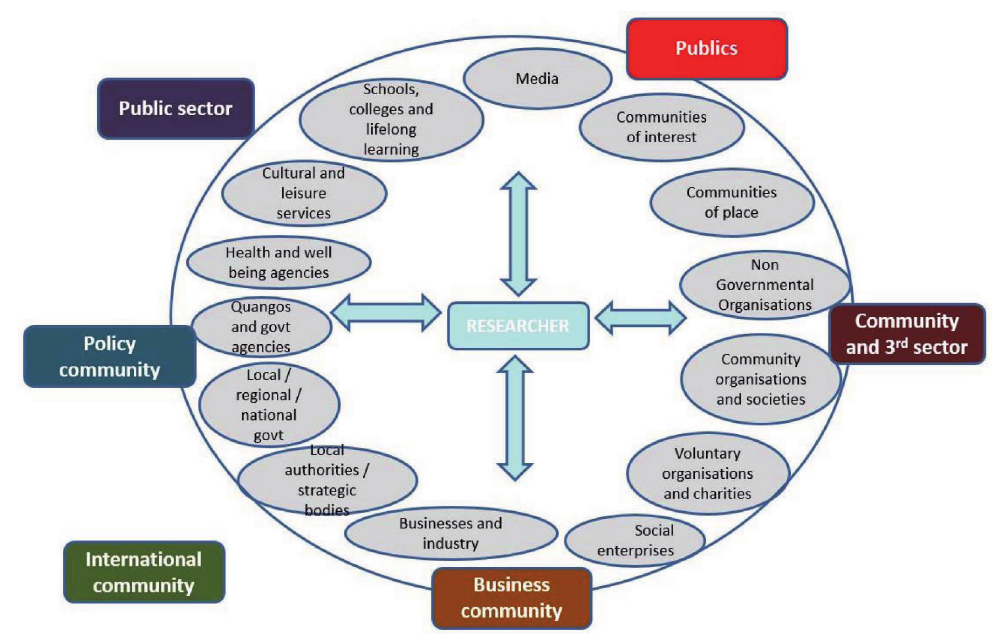
Figure 1: Mapping the different external groups with whom researchers might engage